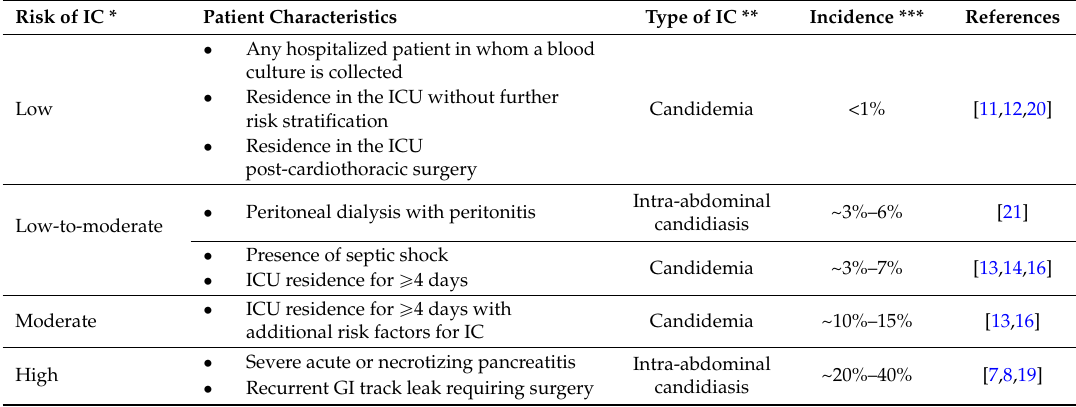
Table 1. Incidence of invasive candidiasis in various